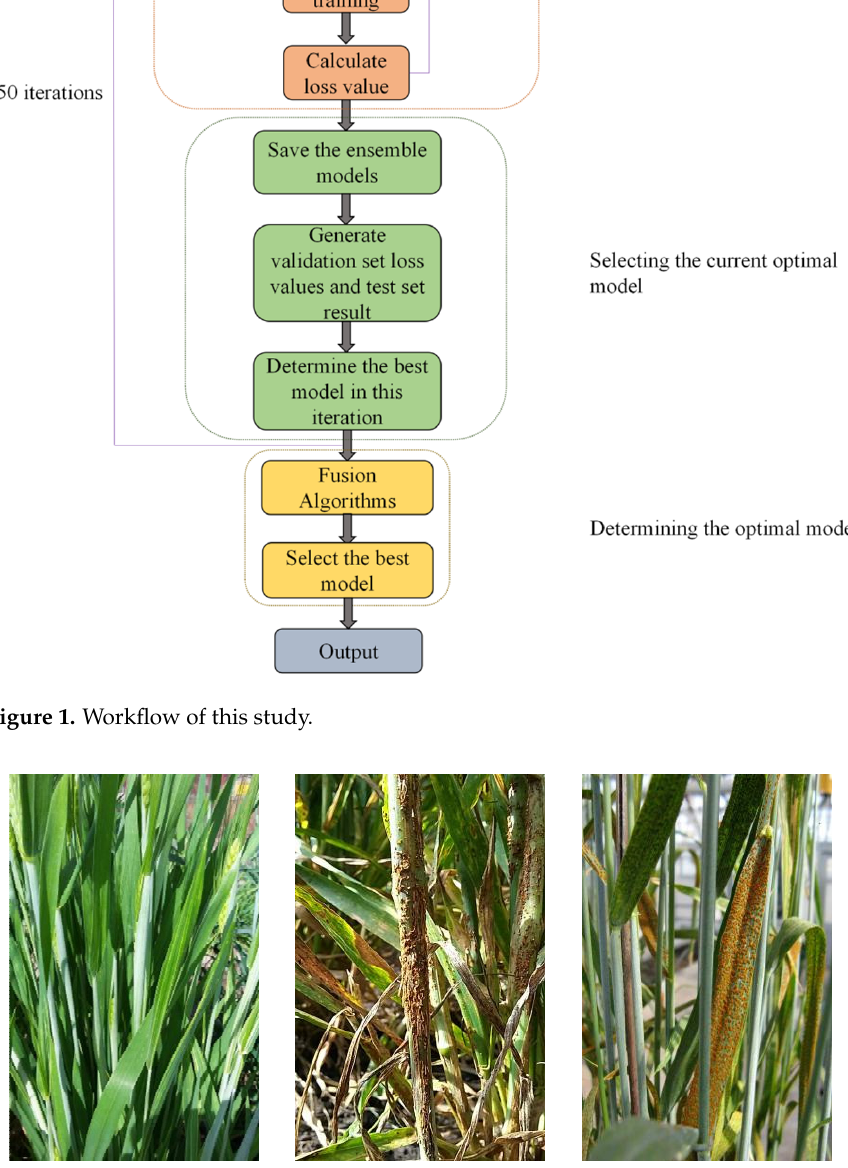
Figure 2. Sample images from the dataset used in this work. ( a ) Healthy wheat; ( b ) Stem rust wheat; ( c ) Leaf rust wheat.